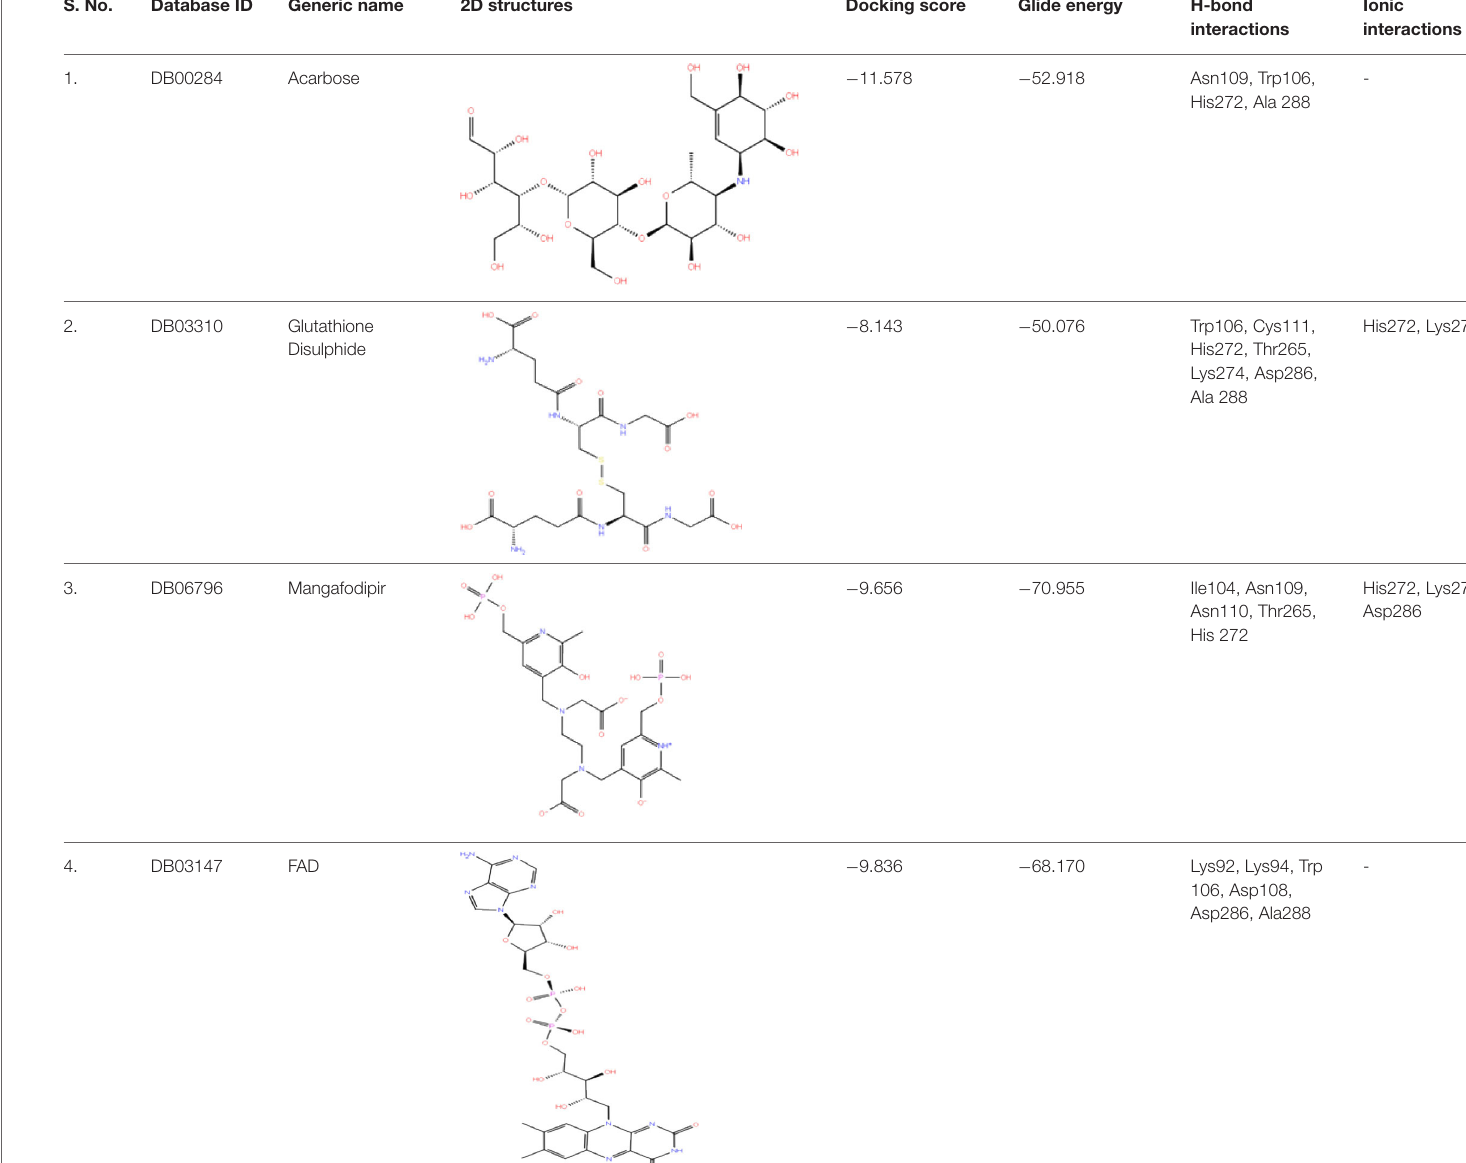
TABLE 1 | List of FDA approved drugs screened against SARS-CoV-2 PLpro by in silico screening. S.